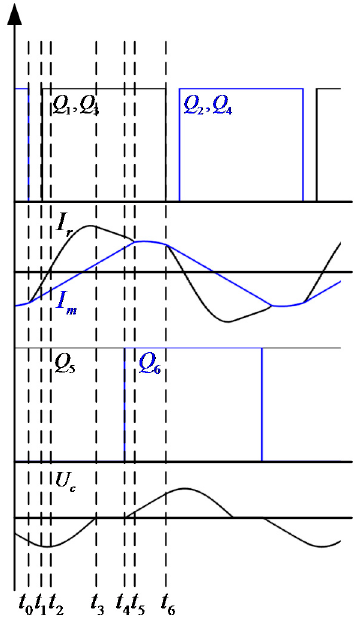
Figure 4. Commutation process of the LLSC converter in the boost mode.